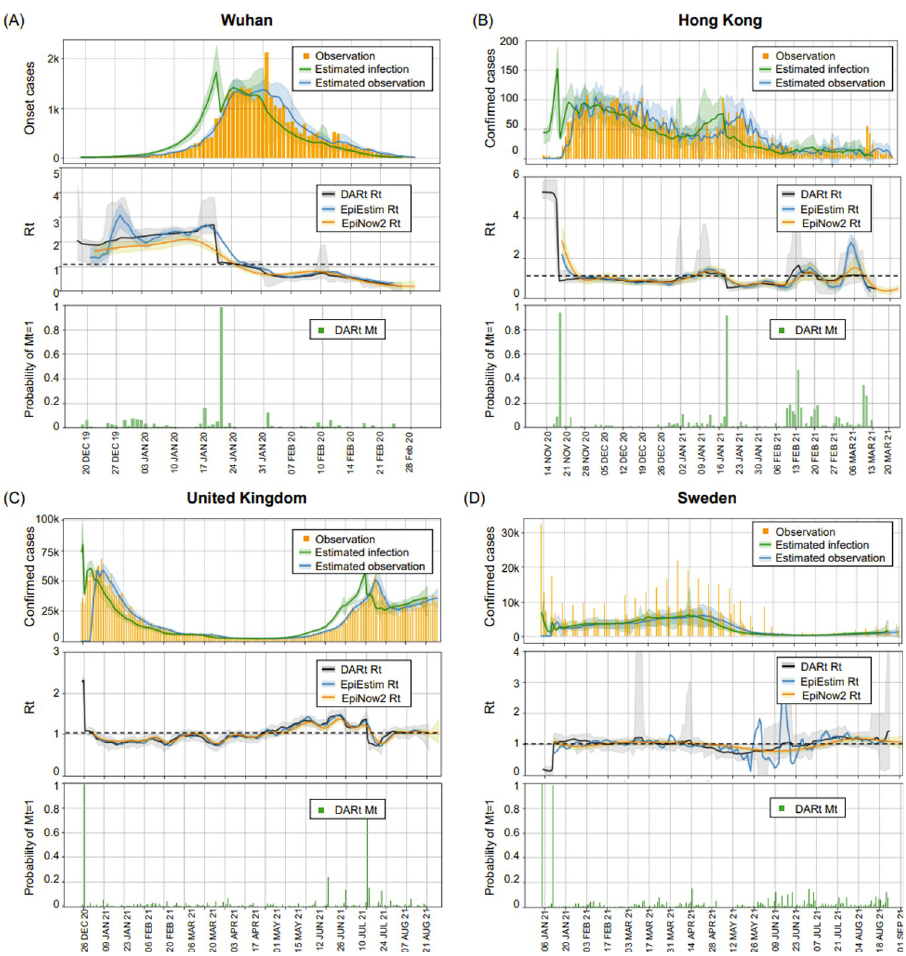
Fig 4. Epidemic dynamics in Wuhan (A) , Hong Kong (B) , United Kingdom (C) and Sweden (D). The top row of each subplot shows the number of daily observations (in yellow), the estimated daily observations (in blue) and the estimated daily infections (in green). The middle row compares the DARt R estimation (in black) with the EpiEstim t results (in blue) and EpiNow2 (in yellow). The distributions of all estimated R t are with 95% CrI. The bottom row = 1) (in green shows the probabilities of having abrupted changes ( M t